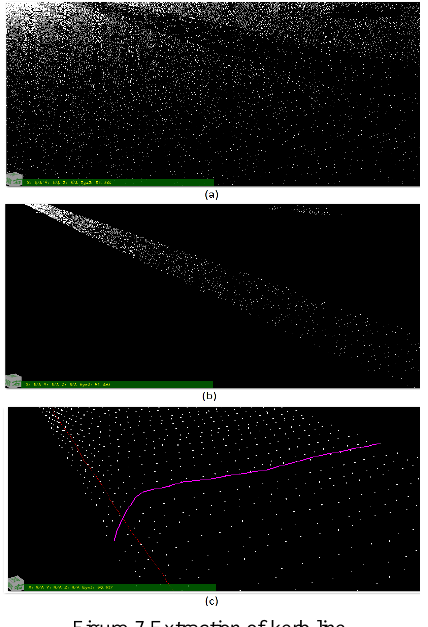
Figure 7.Extraction of kerb